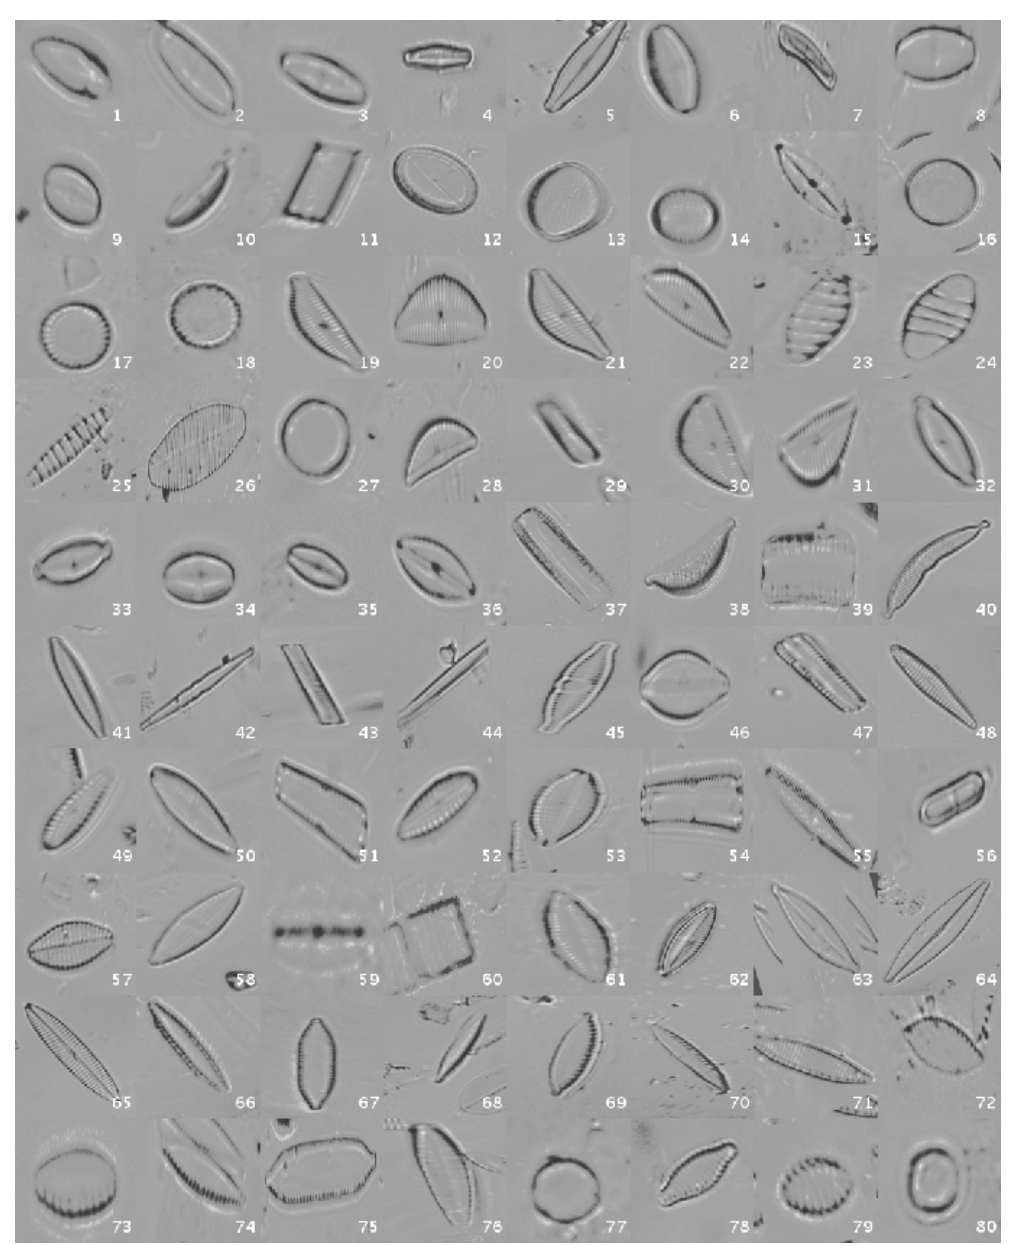
Figure 3. Diatom examples in the normalized